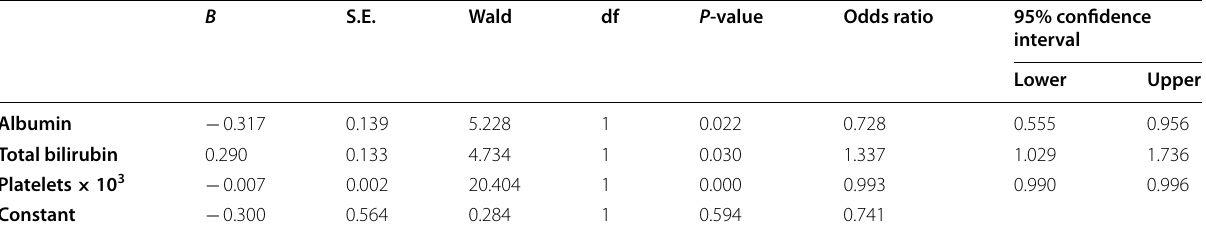
Table 4 Prediction of hepatic decompensation using predicted probability from the multivariate logistic regression model